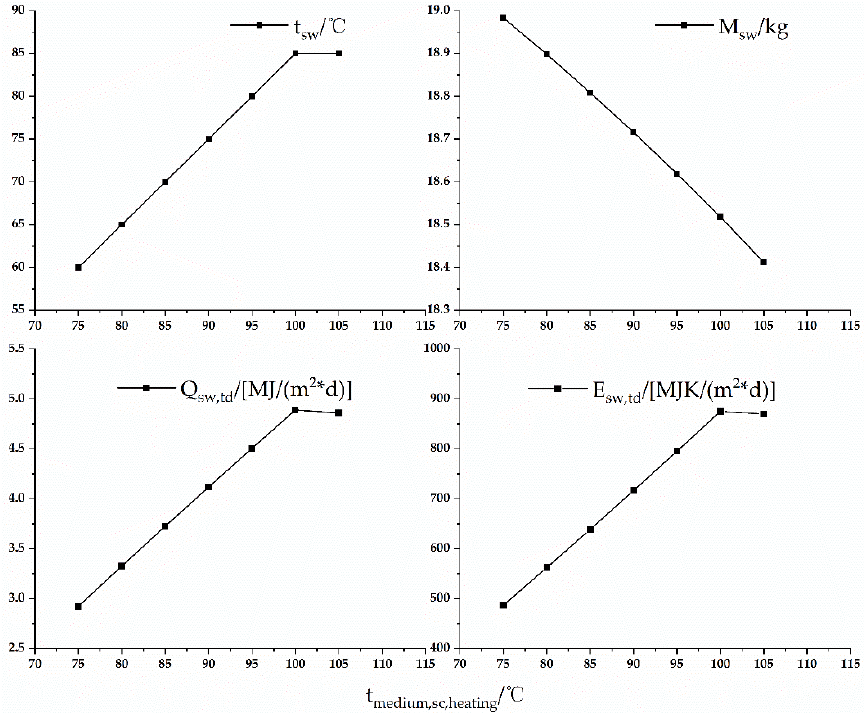
Figure 15. Variations in the key parameters with the medium temperature of solar collection in the heating season.